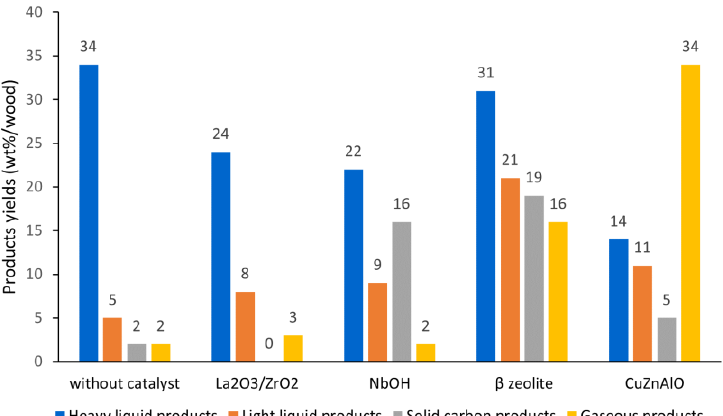
Figure 6. Yields of gaseous, heavy liquid, light liquid and solid products resulting from the solvolysis of pine in SC ethanol at 250 °C in the presence of different types of catalysts. Conditions: 2.5 g of Pin, 1 g of catalyst, 27 g of ethanol, at 250 °C, 1 h.